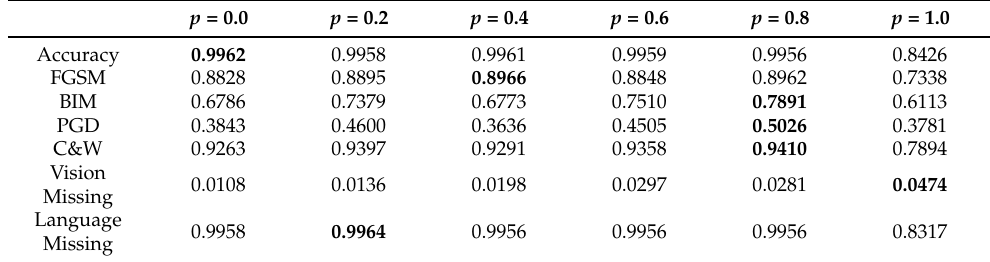
Table 7. Accuracy averages for different cases with different values of the modal deactivation probability p for the Flowers dataset p =